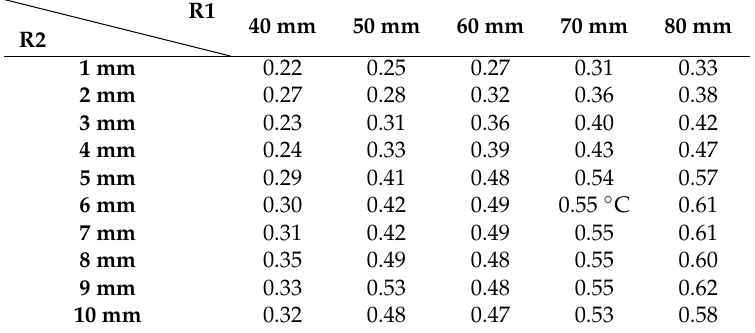
Table 3. Theoretical data for breast cancer analysis at various positions (X = 0, Y =